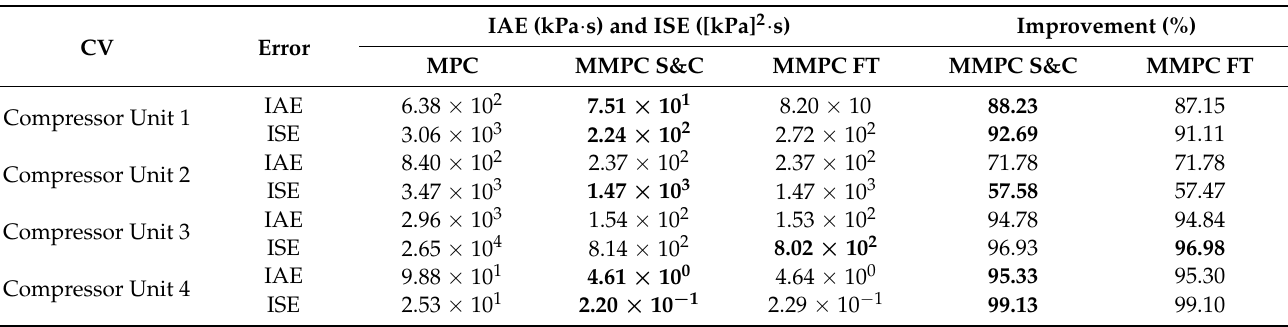
Table 11. Comparison of IAE and ISE on the compressor unit with changes on compressor unit 1 (MIMO Model 2).